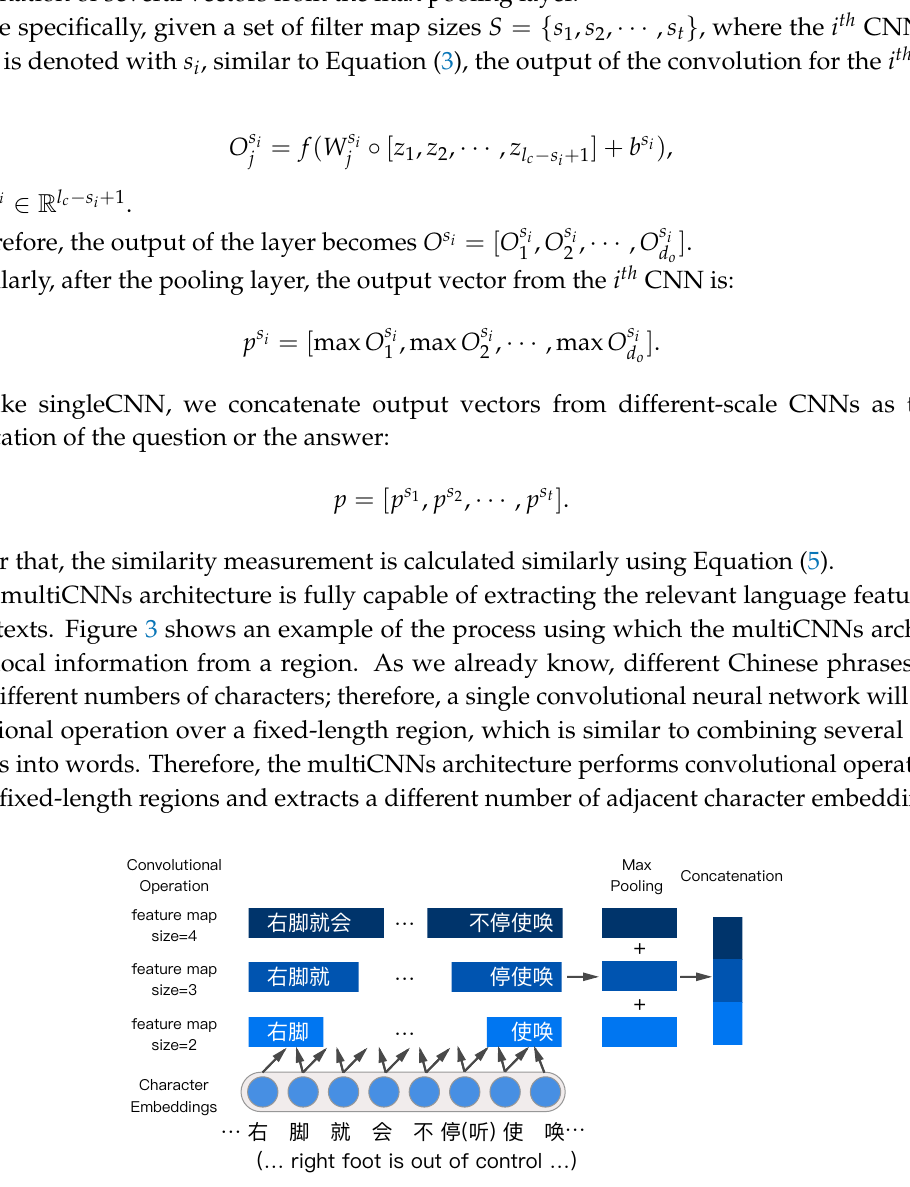
Figure 3. A multi-scale convolutional neural networks architecture. The architecture extracts local features of character embeddings using multi-scale convolutional feature maps. The features are then fed into max pooling layer to reduce the representation. After that, vectors from the pooling layer are concatenated into a single